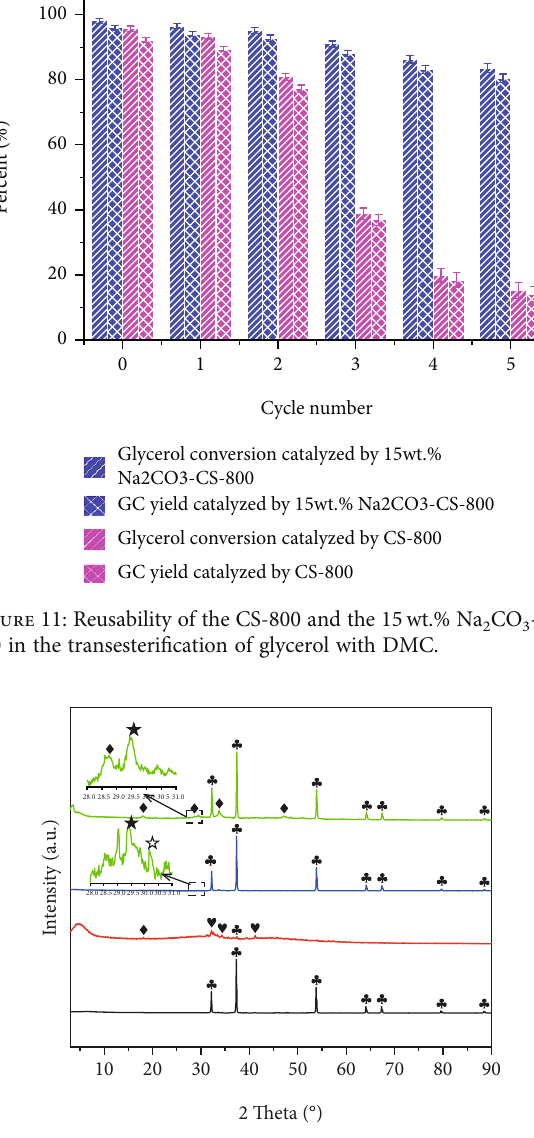
Figure 12: XRD patterns of (a) the CS-800, (b) the reused CS-800, (c) the 15wt.% Na CO -CS-800, and (d) the reused 15 wt.% 2 3 Na CO -CS-800. 2 3